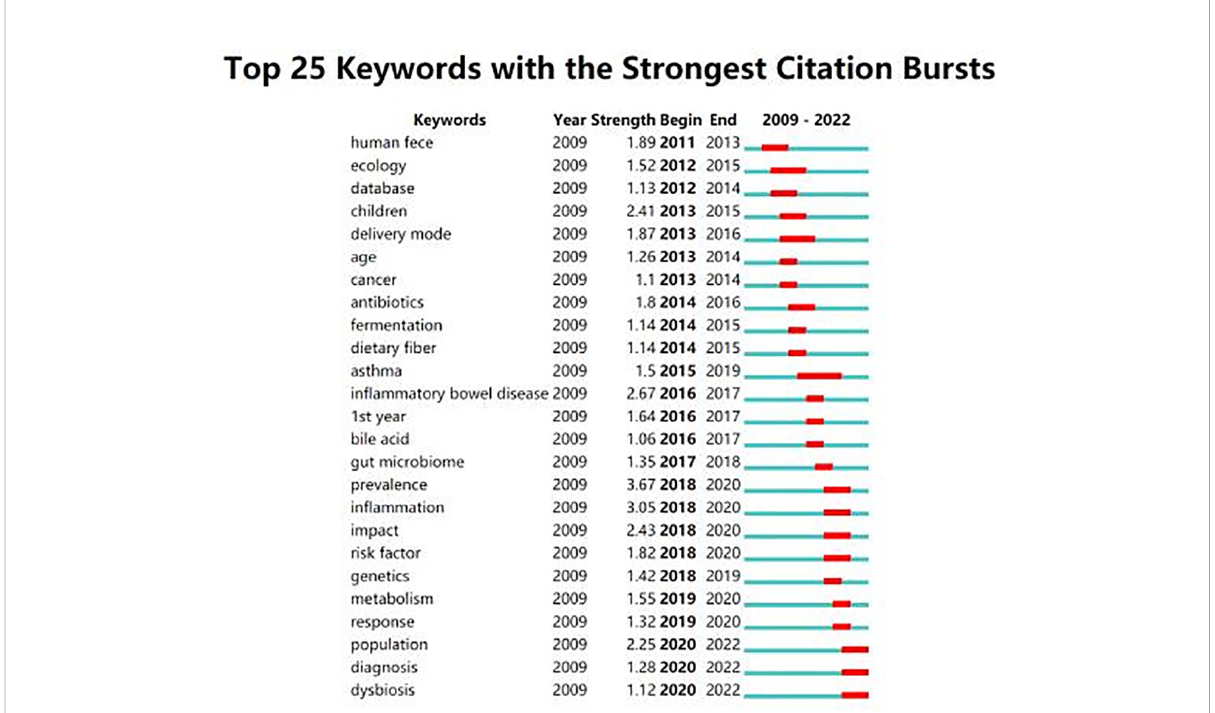
FIGURE 5 Keywords with the strongest citation bursts. The keywords with high frequency change rate and fast growth rate that can re fl ect the frontiers of research based on minority gut microbes between 2009-2022.